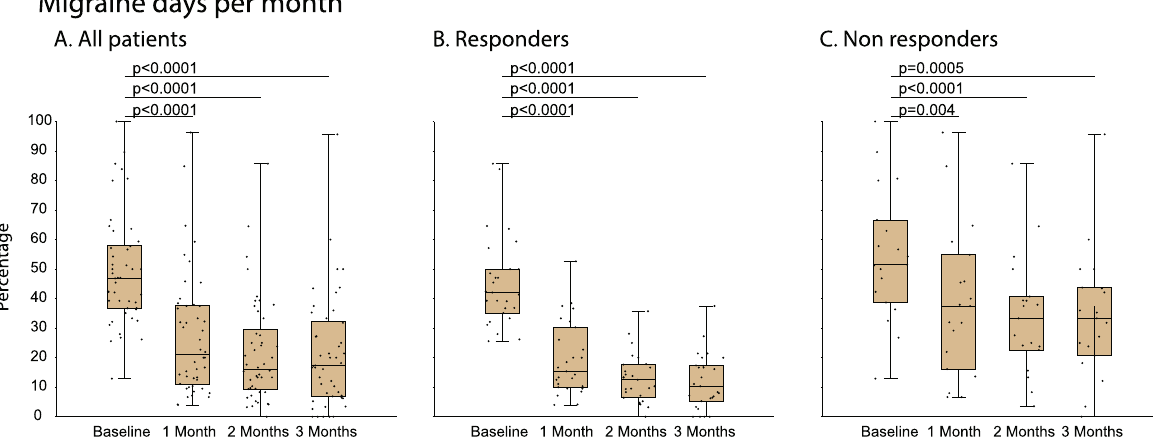
Fig. 4 Galcanezumab effects on migraine days per month in ( A ) all 46 patients, ( B ) 24 responders only, and ( C ) 19 non‑responders. Differences in percentages of migraine days per month at baseline (before treatment) and in each of the 3 treatment months are shown in box‑and‑whisker plots (median [IQR]) combined with scatterplots of individual values. Note that the percentage of migraine days per month decreased significantly, although to a different extent, in all 3 groups